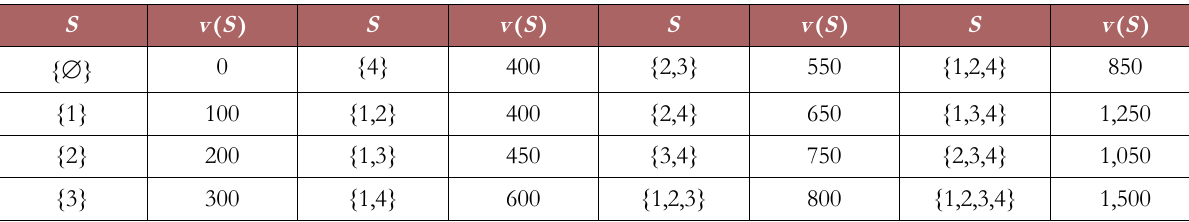
Table 1. Characteristic function of the beer game. Ponte et al. (2016, p.